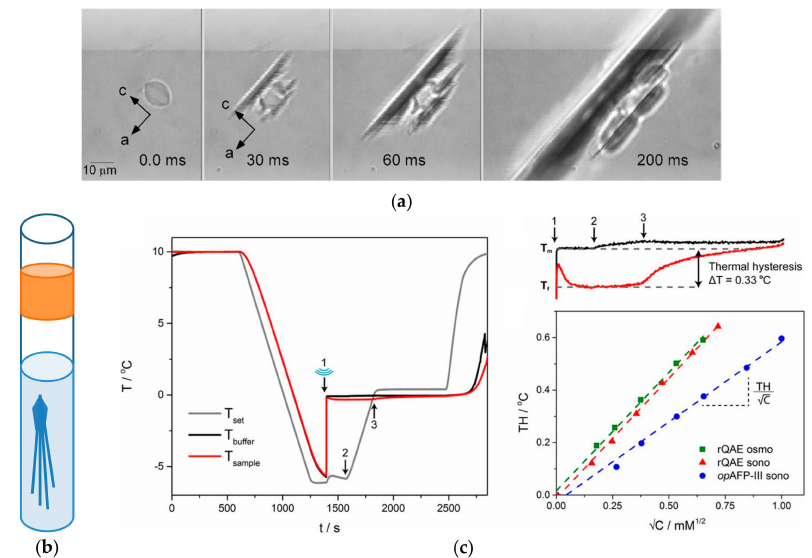
Figure 6. Di ff erent methodologies to quantify the thermal hysteresis (TH) activity of AF(G)P solutions. TH determined by ( a ) nanoliter osmometry (crystallographic a and c-axes are indicated) Adapted